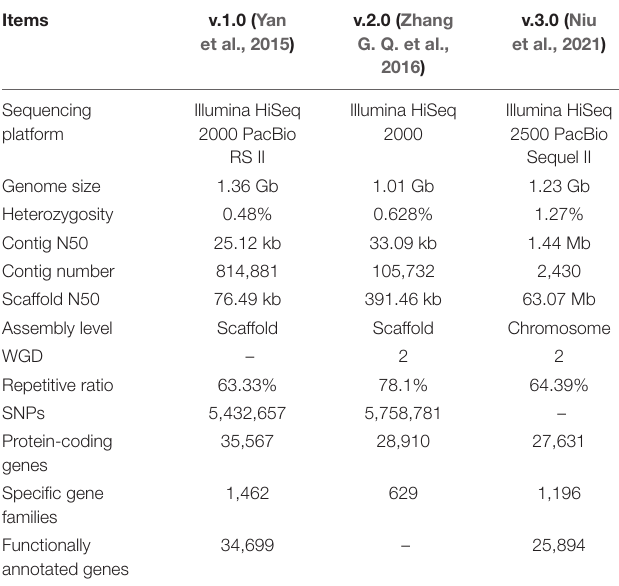
TABLE 1 | A quality comparison of three D. officinale genome versions.